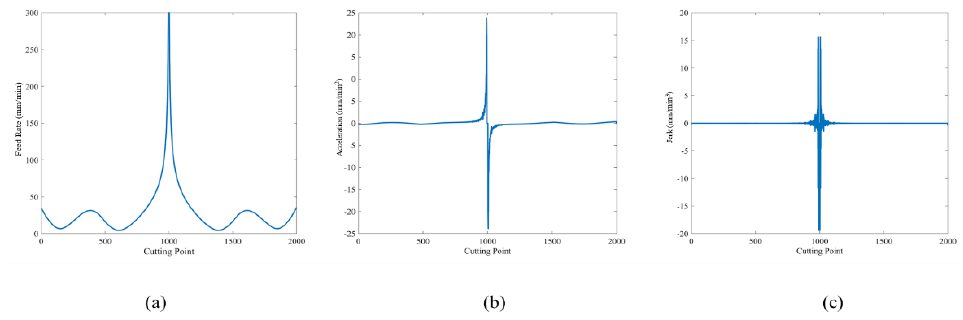
Figure 16. Cutting ∞ shape using method by Giannelli et al. [11]: ( a ) feed rate, ( b ) acceleration, and ( c ) jerk.